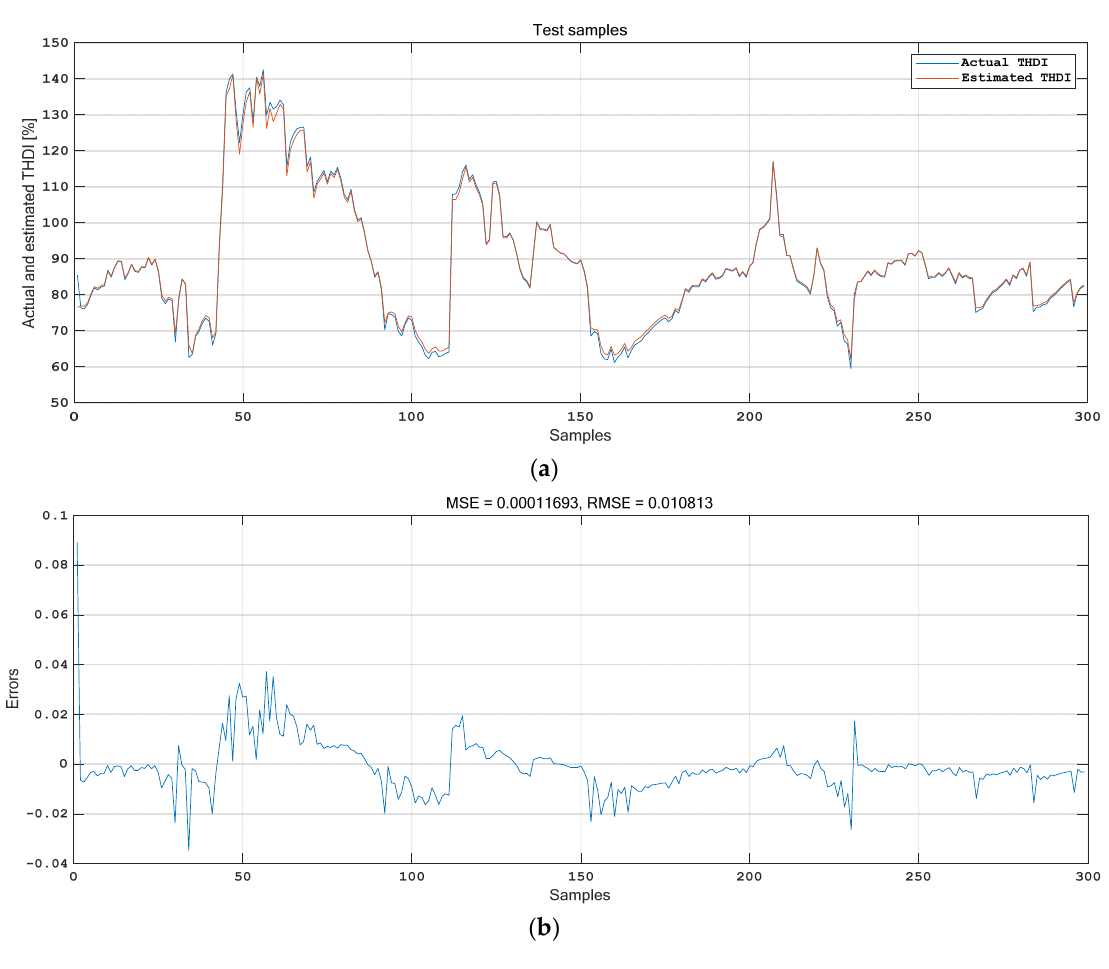
Figure 12. THDI variation ( a ) and errors variation ( b ) for testing data for the following parameters: nMax = 16, maxL = 6, α = 0.5, m = 5, and pTrain = 70%. Error Mean = -0.00097598, Error StD = 0.010787